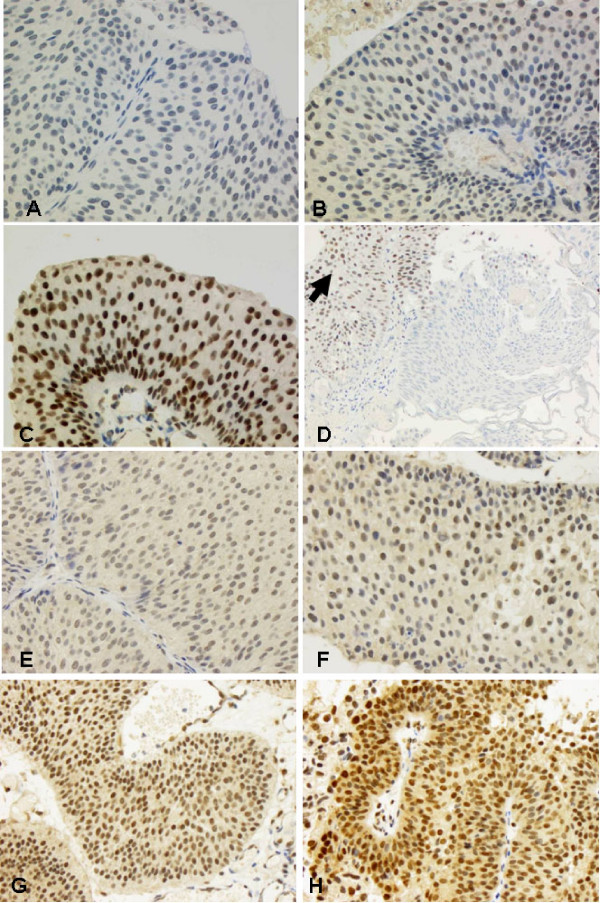
FBP1 and FBP3 expression in normal urothelium and cancer of the urinary bladder. Papillary bladder cancer with weak (A), with moderate (B), and with strong (C) expression of FBP1 (all 20×). D) Illustration of the heat sensitivity of the FBP1 epitope, which is not detectable in coagulated areas (centrally), whereas the signal is well retained at the periphery (arrow). Papillary bladder cancer with weak (E, 20×), moderate (F, 40×; G, 20×)), and with a strong (H, 40×) expression of FBP3, respectively.